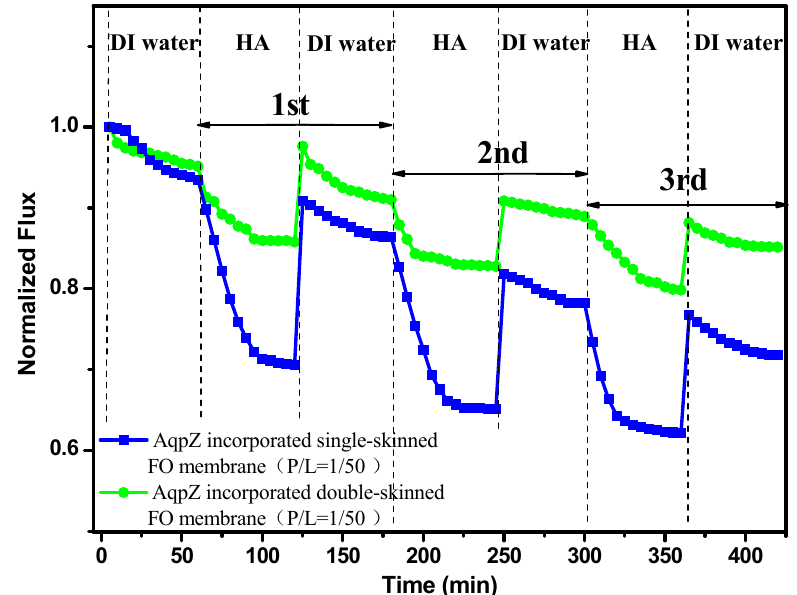
Figure 8. Normalized fluxes of AqpZ-incorporated single-skinned and double-skinned FO membranes during three cycles of humic acid (HA) solution and DI water FO